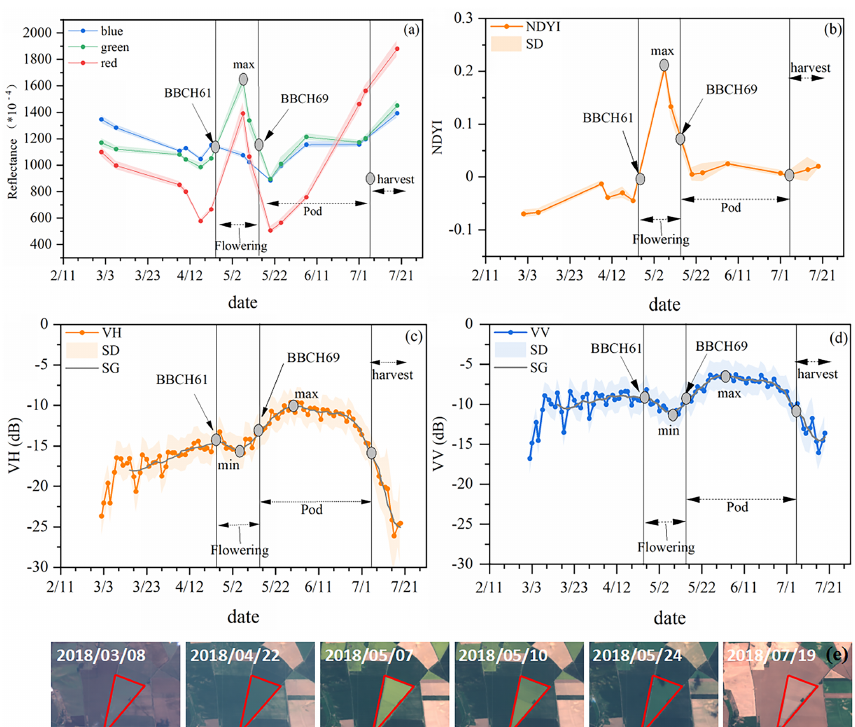
Figure 2. Time-series profiles of four features of rapeseed pixels around one DWD station (ID = 13126; longitude: 11.333268424 ◦ E, latitude: 52.200000463 ◦ N) in Germany in 2018. (a) Mean reflectance values (red, green, and blue). (b) Mean NDYI. (c) Mean VH. (d) Mean VV. The light-shaded areas indicate the standard deviation. The BBCH scale was used for in situ observations of rapeseed phenology, with BBCH61 and BBCH69 respectively corresponding to the start and end of flowering. (e) The rapeseed parcel around the DWD station is bounded in red (image source: Copernicus Sentinel-2 data